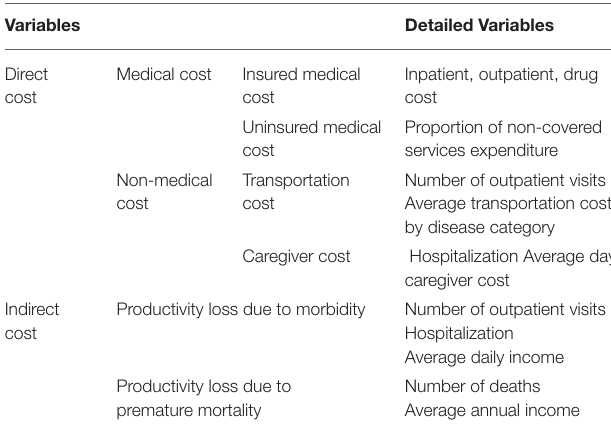
TABLE 1 | Economic disease burden